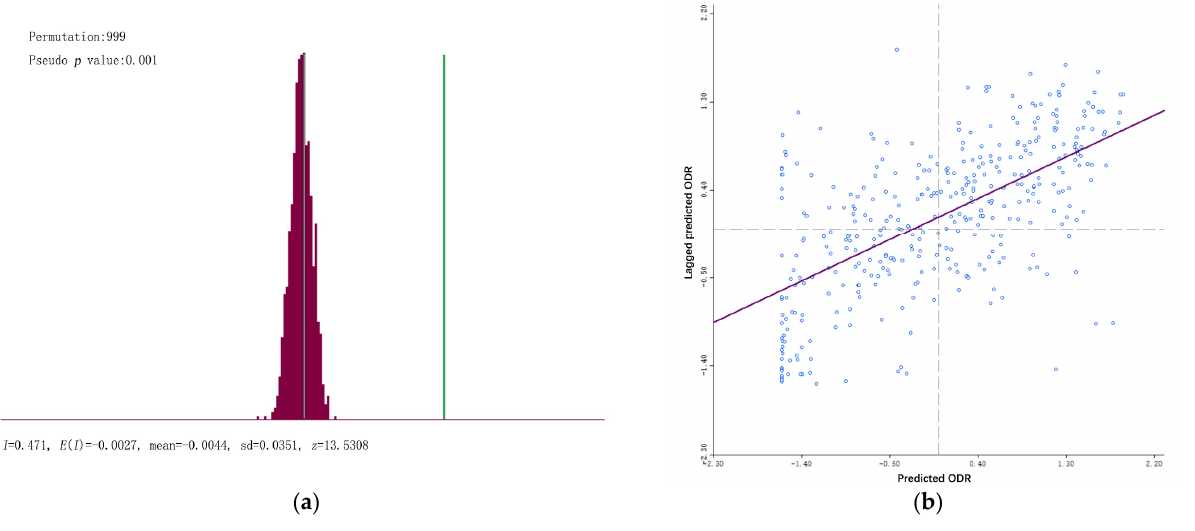
Figure 4. Global spatial autocorrelation analysis of the municipal ODR. ( a ) Significance distribution of the z value; ( b ) Scatter plot of the global Moran’s I . Table 5. ODR values in the hot spot